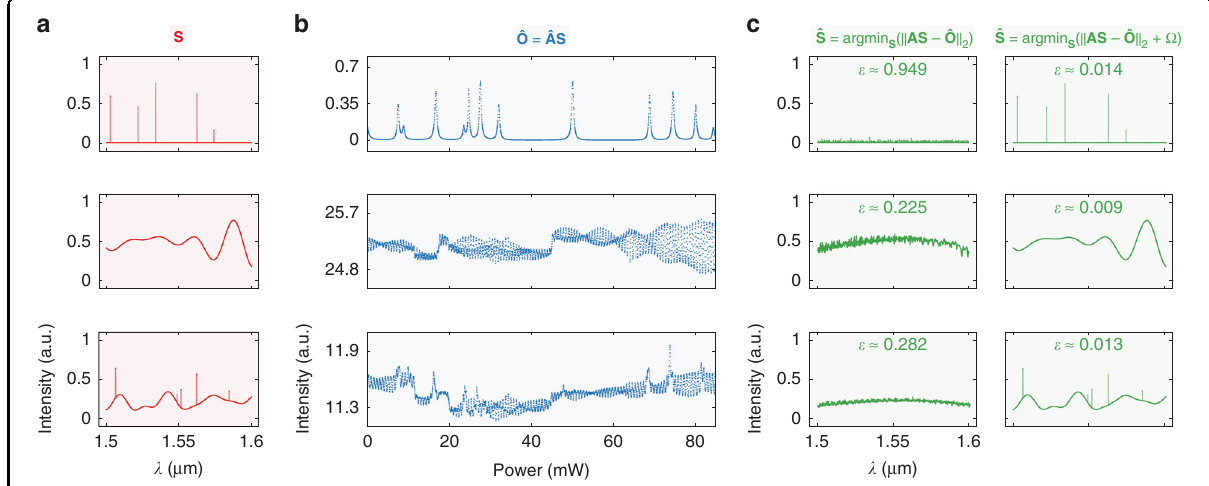
Fig. 5 Numerical reconstruction of spectra. a Testing input spectra ( S ) with discrete, continuous, and hybrid features. b Calculated output signals ( Ȏ ). Here, Â denotes the transmission matrix under emulated thermo-optical perturbations. c Reconstructed spectra ( Ŝ ) with relative errors ( ε ) labeled. In the fi rst and second columns, we present the reconstruction results with and without penalty terms ( Ω ),